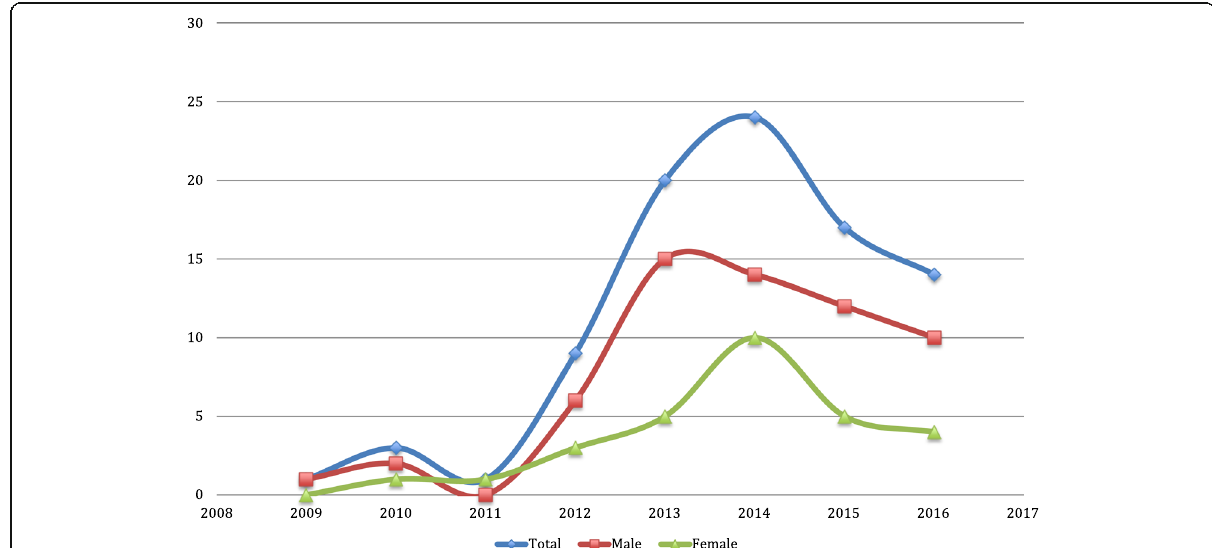
Fig. 1 Number of deaths among street-connected young people in Eldoret, Kenya stratified by sex from October 2009 to December